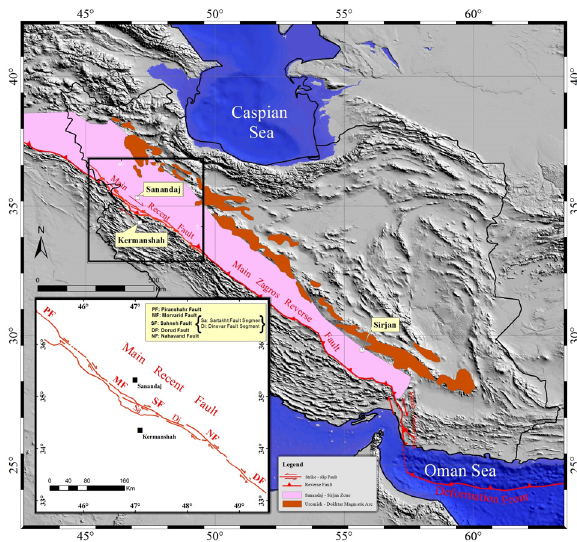
Figure 2. Potential seismic sources in the Kermanshah-Sanandaj region [Shabani and Mirzaei